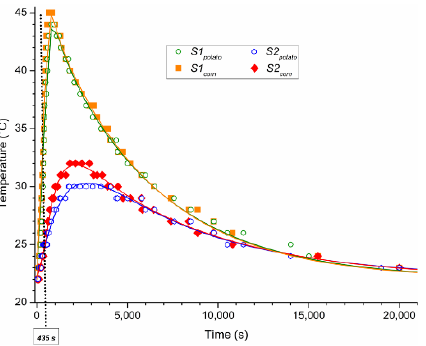
Figure 2. Temperature profiles through sensors S1 and S2 for both irradiated potato and corn starches.